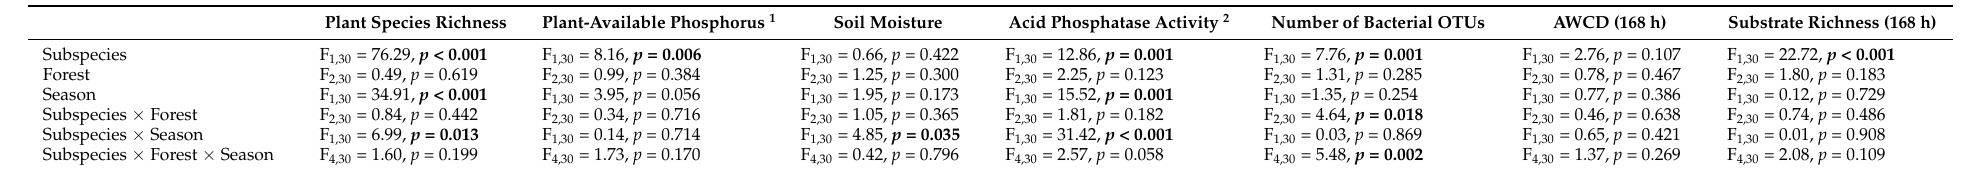
Table 2. Summary of linear mixed effects models testing the effects of subspecies ( L. g. argentatum vs. L. g. galedobdolon ), forests (three sites), season (spring, autumn) on plant species richness (number of species per 3 m 2 ) and various soil properties. In all analyses, we considered the difference in a variable between plots containing one of the Lamium subspecies and their corresponding control